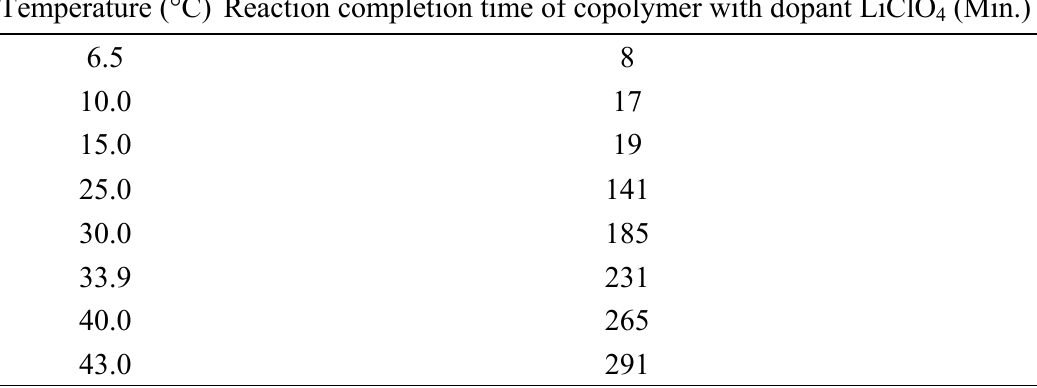
Table 7. Temperature vs. Reaction Completion Time of Copolymer with